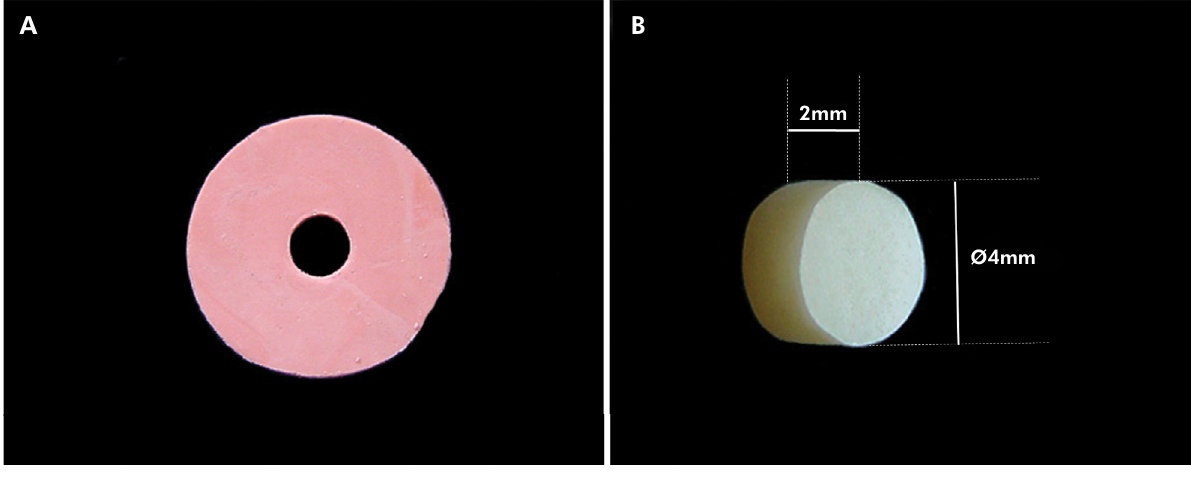
Figure 2. Rubber mold (a) and Test specimen geometry